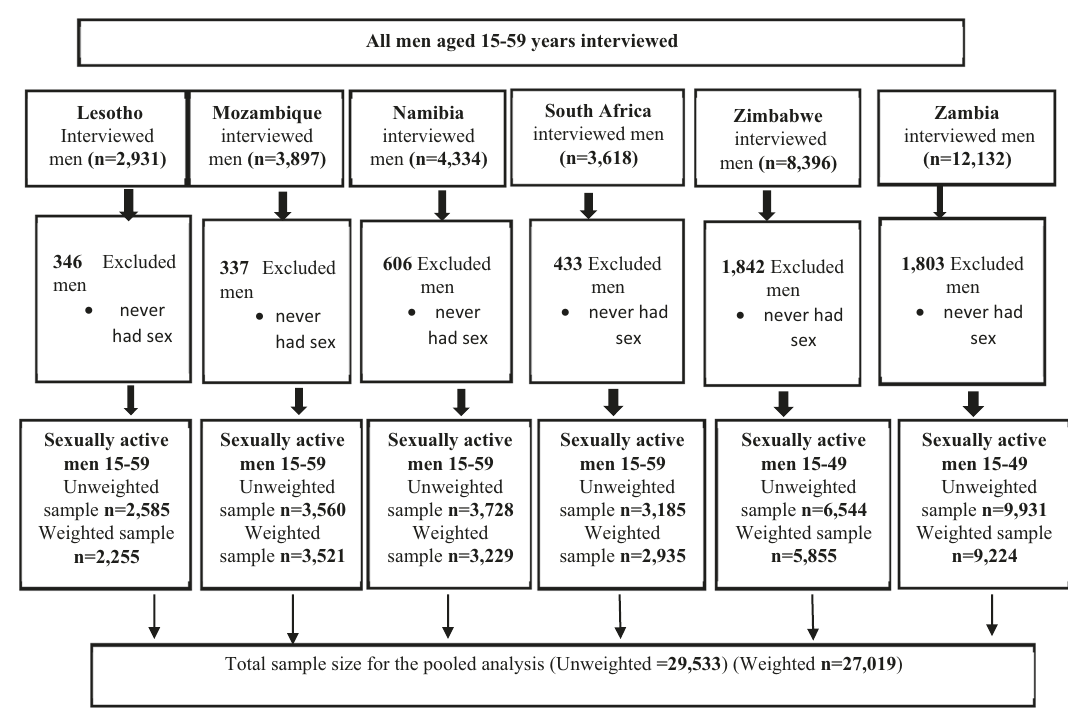
Fig. 1 Sample derivation